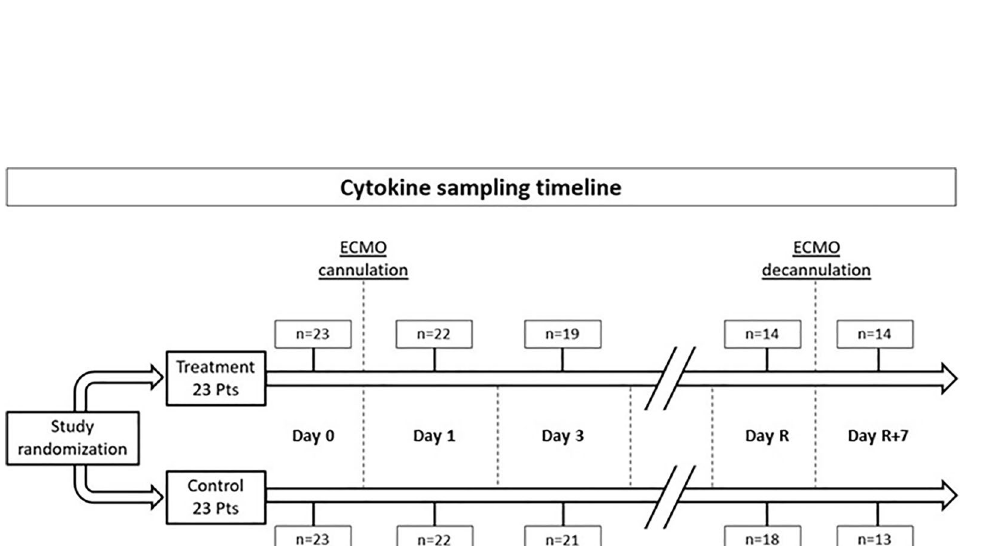
Figure 1. Cytokine sampling time during the study. Timepoints: Day 0 (prior to ECMO start), Day 1 (24 h after ECMO start), Day 3 (72 h after ECMO start), Day R (before ECMO removal), Day R + 7 (7 days after ECMO removal or before discharge from the ICU whichever happened first). n number of patients